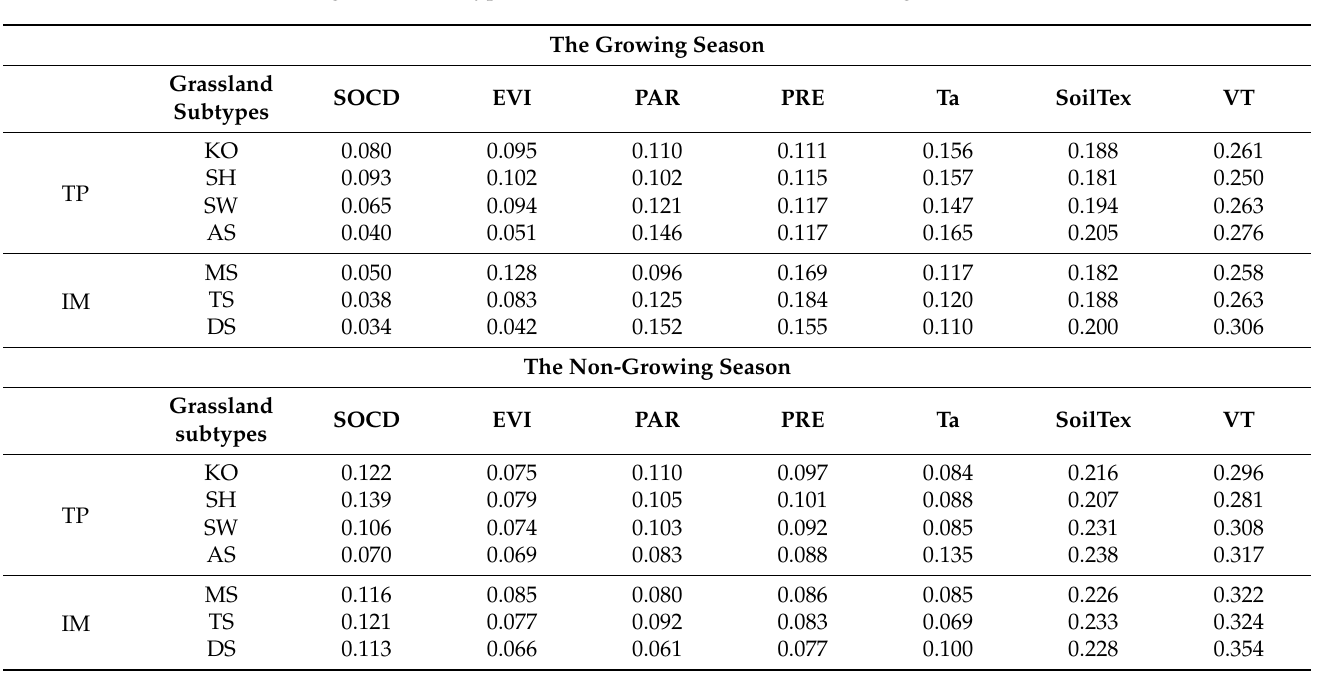
Table 3. Relative importance statistics for the environmental variables. All the notations in the grassland subtypes column are consistent with those in Figure